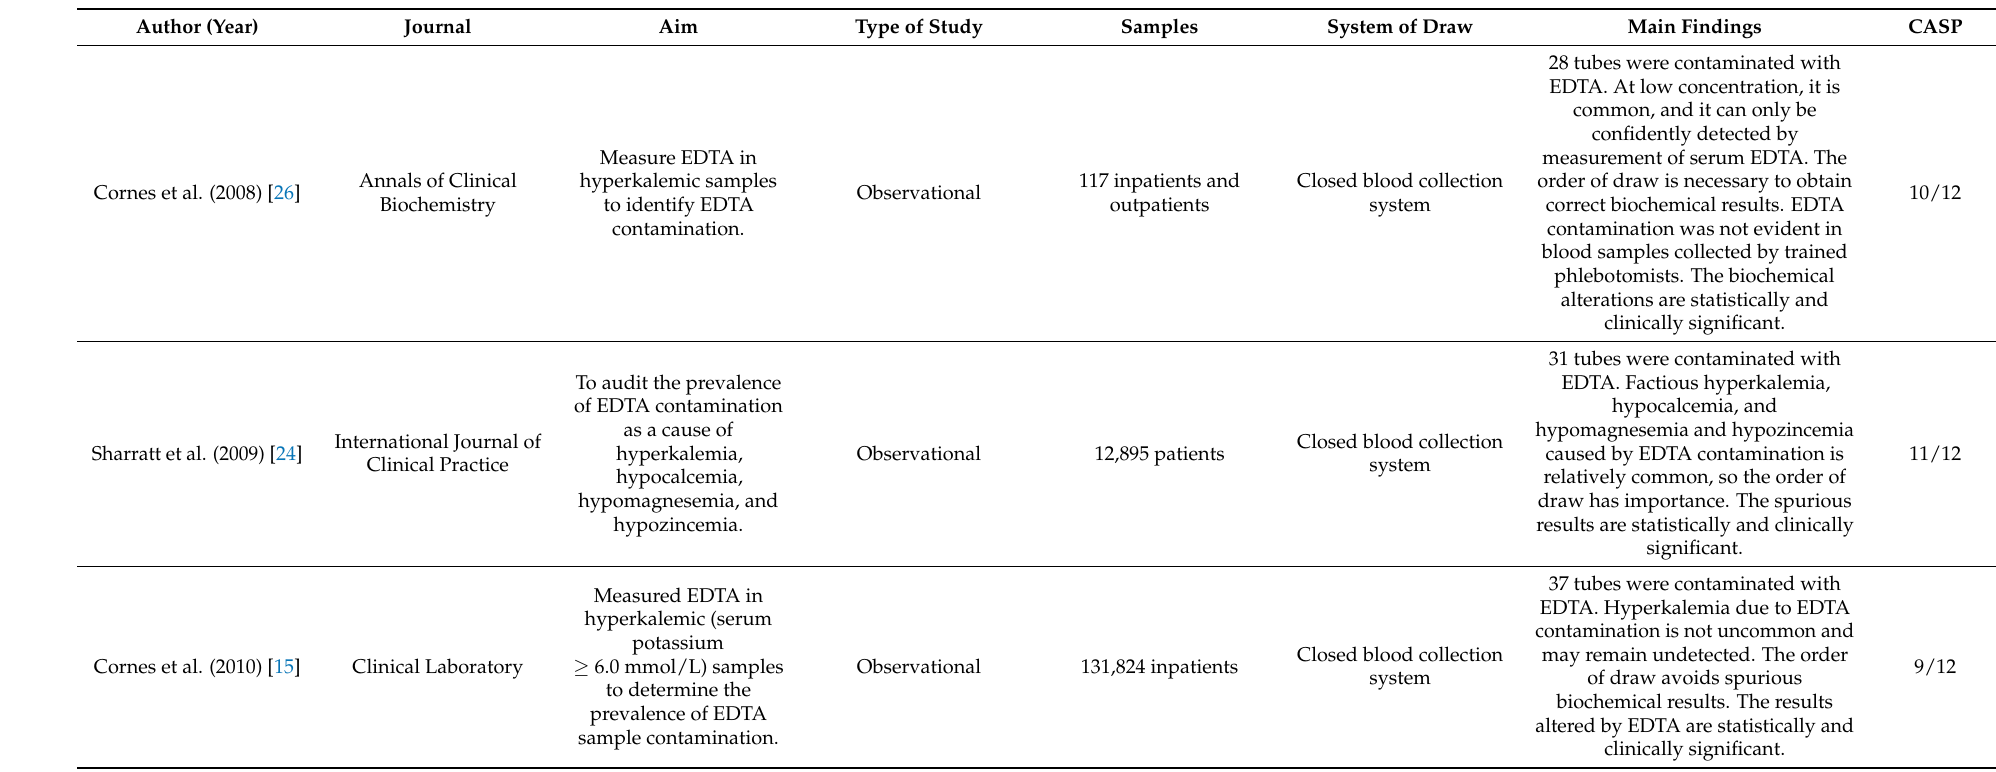
Table 1. Summary of selected